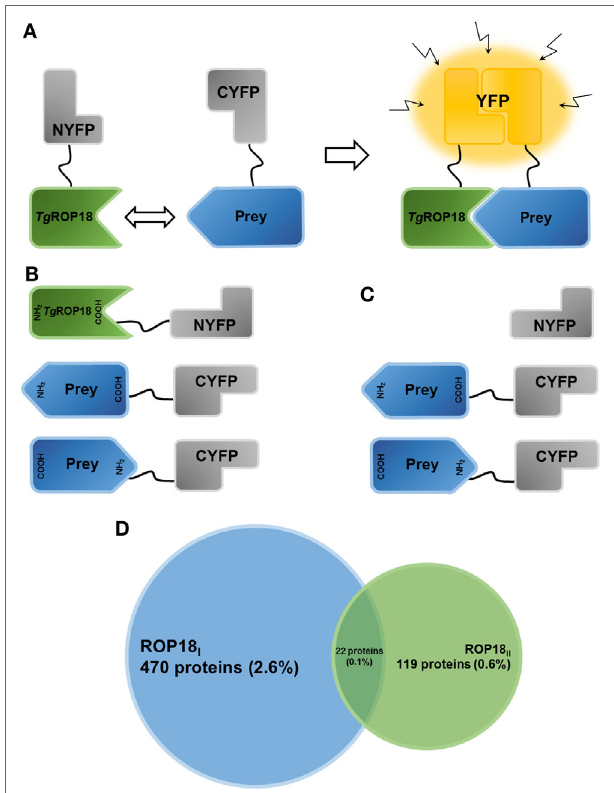
FigUre 1 | Establishment of the HT-BiFC screening system and Tg ROP18- interacting proteins. (a) Principle of the bimolecular fluorescence complementation (BiFC) assay. The non-fluorescent fragments of a fluorescent reporter protein are fused with the proteins of interest and expressed in human cells. If the interaction between the proteins of interest takes place, the split fragments will be pulled close enough to refold together and reconstitute the functional fluorescent entity. (B) Schematic representation illustrating the Tg ROP18/prey BiFC constructs generated in the present study. Tg ROP18 is fused with the N-terminal fragment of YFP (NYFP) at the C-terminus, and the prey protein is tethered with the C-terminal fragment of YFP (CYFP) at either the N- or C-terminus. (c) Schematic representation illustrating the control screening. Non-fused NYFP is mated with each CYFP-prey/prey-CYFP constructs. (D) Venn diagram depicting the number (percentage) of ROP18 I -specific targets (blue), ROP18 II -specific targets (green), and ROP18 I /ROP18 II targets (in the